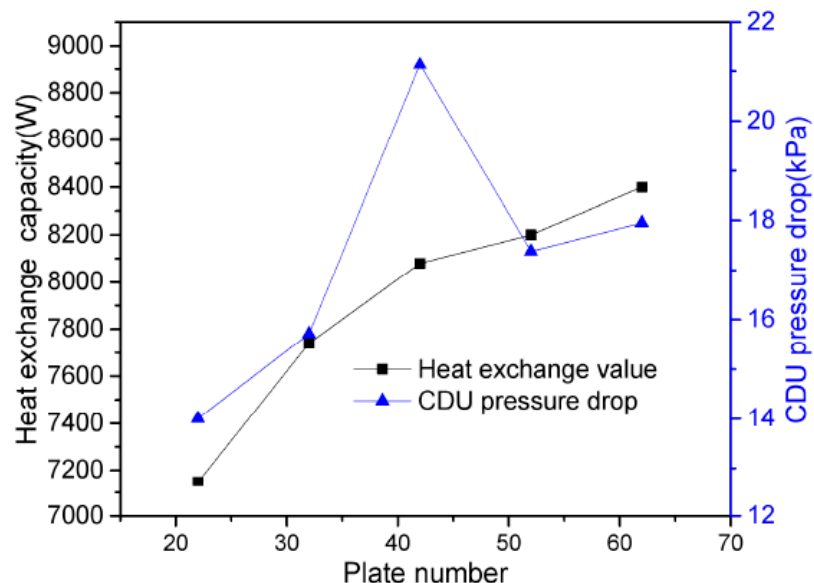
Figure 16. Heat exchange capacity and pressure drop in the evaporator vary with the number of plates.